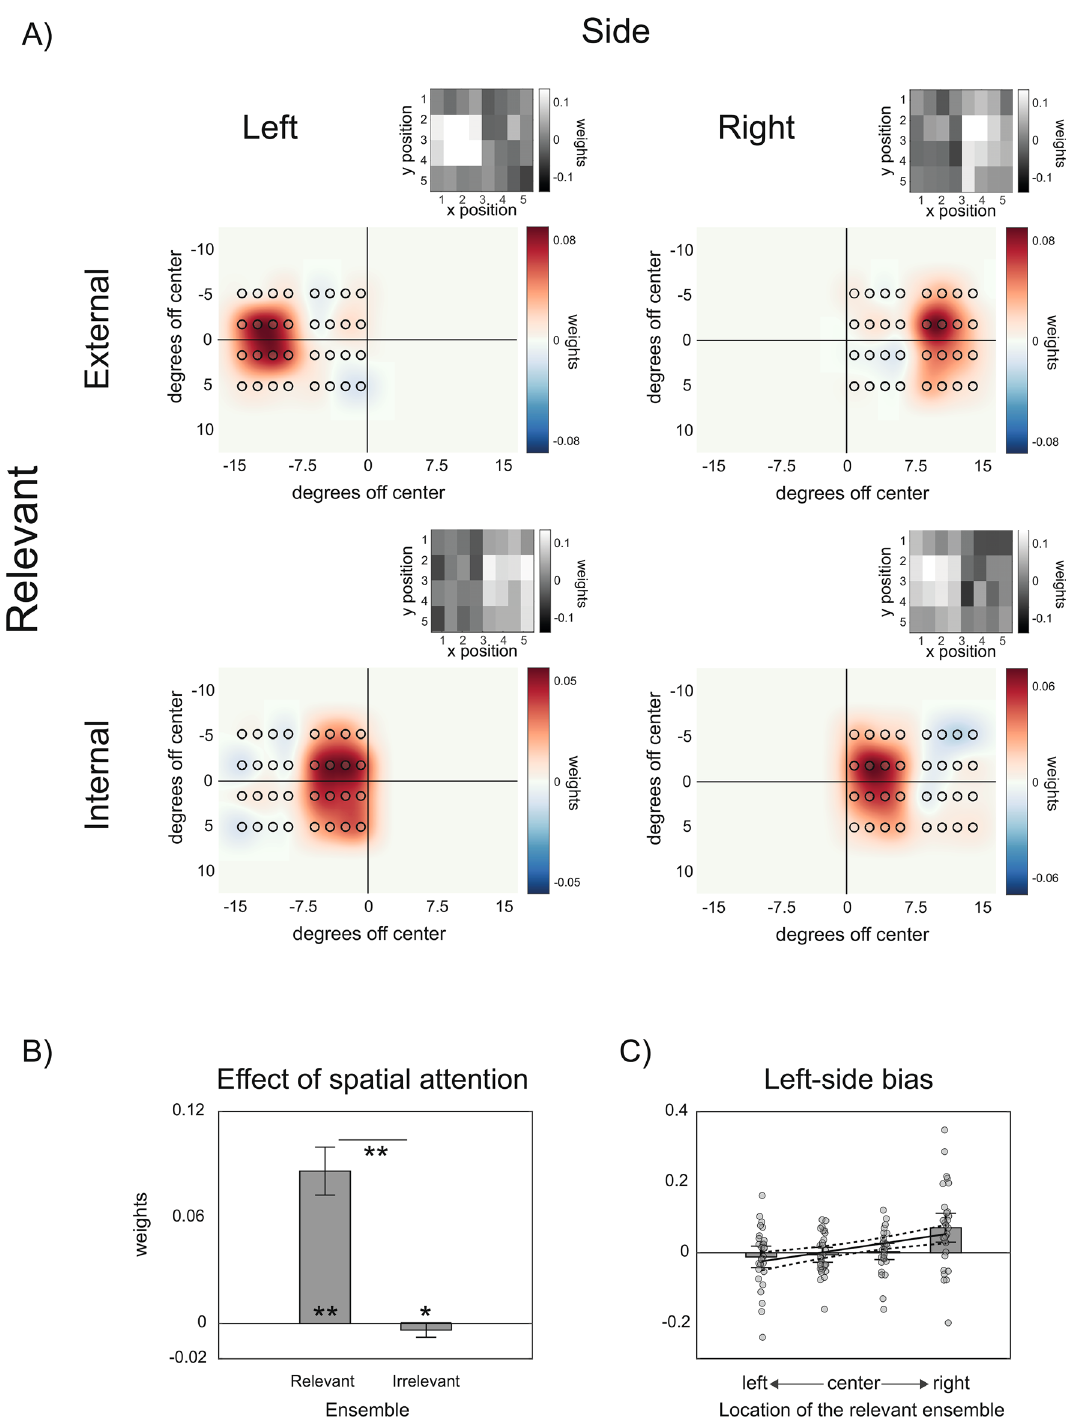
Figure 4. Results of Experiment 3. ( A ) SWM maps for the four combinations of ensemble location (left and right) and relative position of the cued (relevant) ensemble (internal and external). ( B ) Overall weights assigned to stimuli in the relevant and irrelevant ensemble. ( C ) Linear regression on the leftward bias as a function of the actual location of the relevant